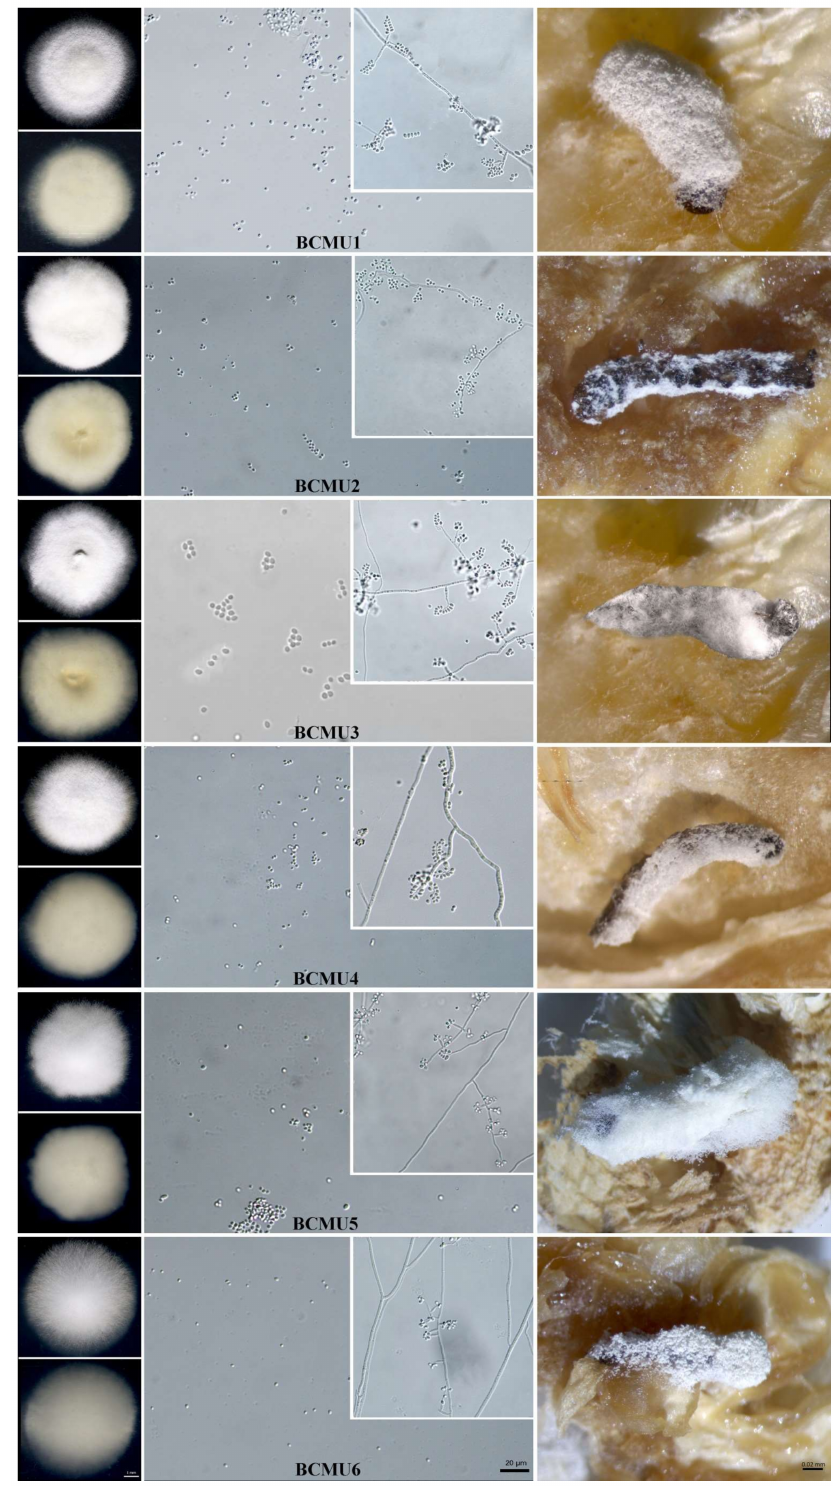
Figure 1. Pictorial presentation of BCMU1–BCMU6 colony on the obverse and reverse sides on PDA media, conidia, and the hyphae and the mycosis caused on Spodoptera frugiperda . Scale Bar = 1 µ m, 20 µ m, and 0.02 mm respectively. The isolates were cultured on potato dextrose agar for 14 days at 25 1 ◦ C with a photoperiod of 12:12 h (Dark: Light). Once the larvae had died, they were placed on moist conditions to allow mycosis.